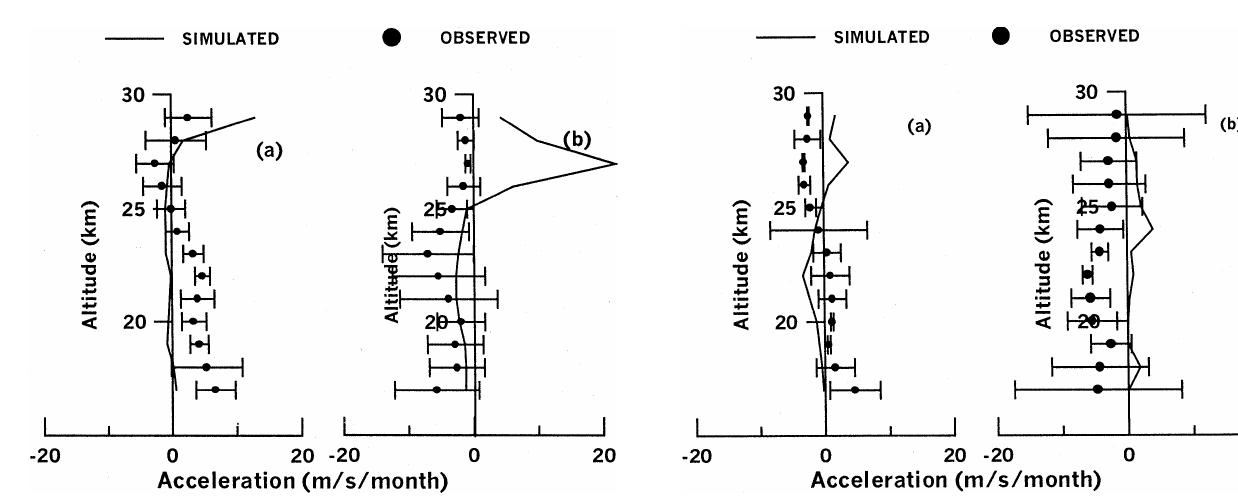
Fig. 4. Same as Fig. 3 but for (a) winter (b)